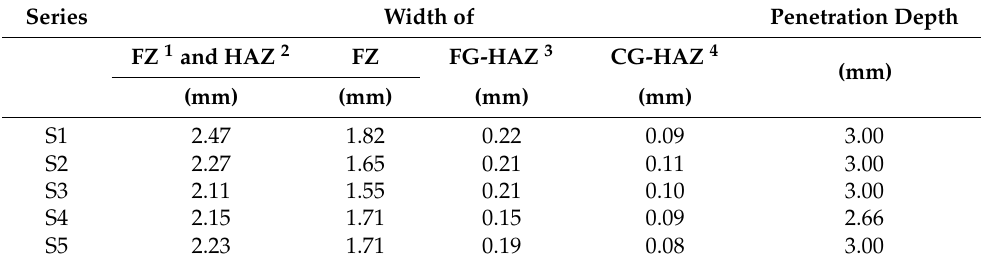
Table 5. Means of macrographs